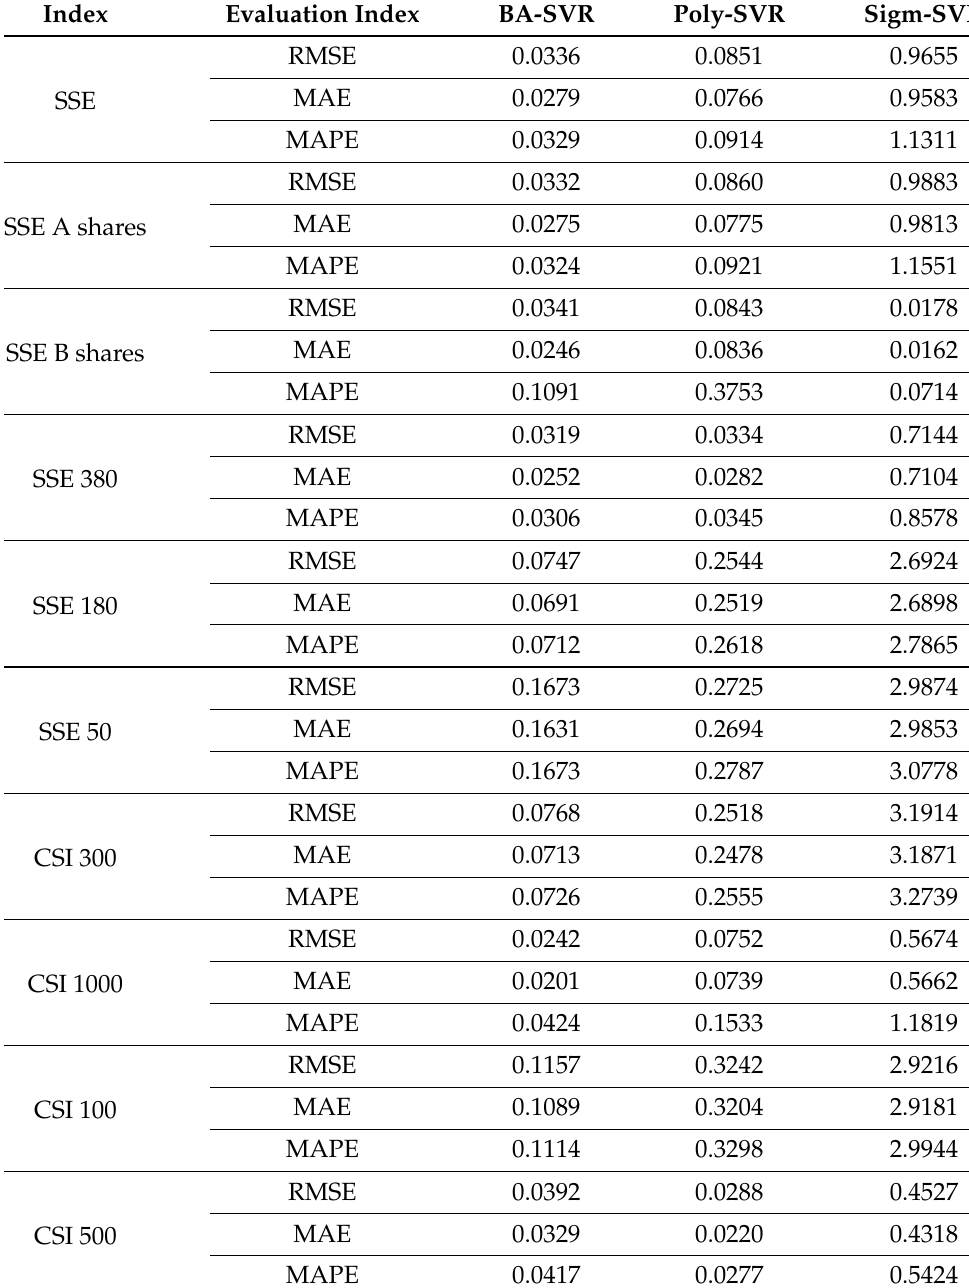
Table 6. The 20-day short-term forecast effect of 18 stock